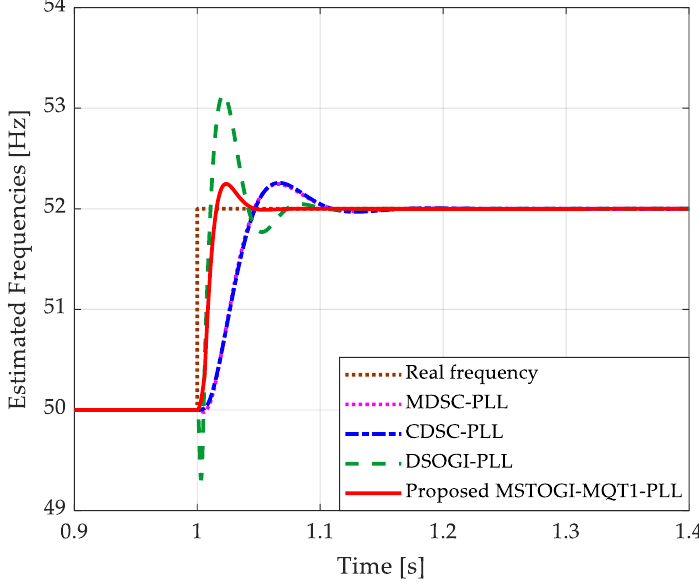
Figure 14. Estimated frequency for all studied methods.